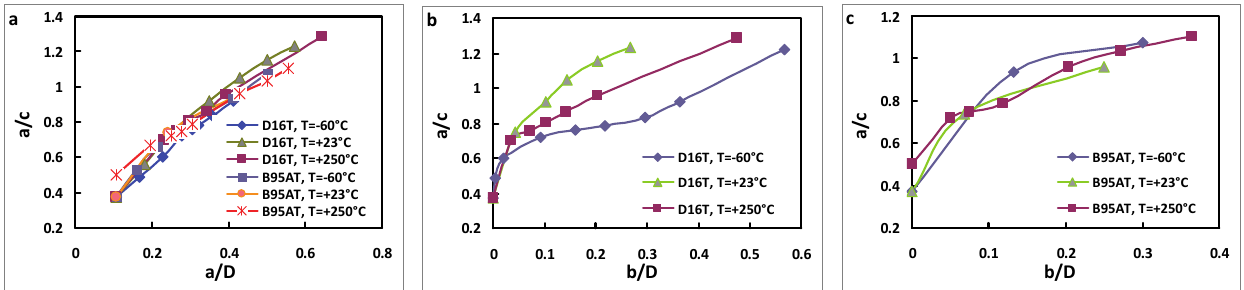
Figure 4: Aspect ratio versus crack depth (a) and crack length (b, c) for both alloys and different temperature conditions. The evolution of the crack growth rate of the elliptical-fronted edge cracks during the tests is determined using CMOD and the microscope. Fig. 5 shows relations between CMOD and crack length b on free surface for both alloys and three temperatures. It is found strong correlation between these two parameters which can be very useful for automation of